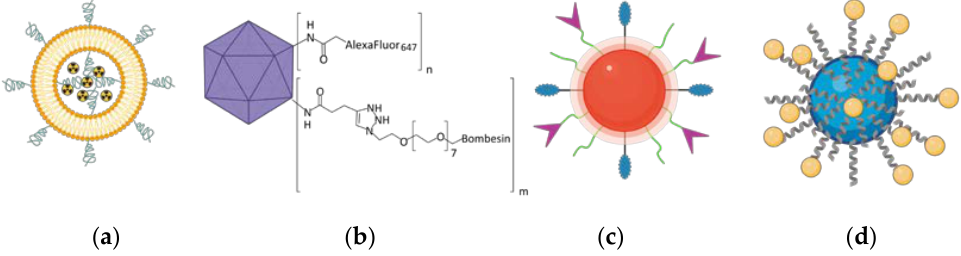
Figure 17. Other representative nanoformulations used for tumor imaging include ( a ) long-circulating, pH-sensitive, BBN-labeled liposomes with 99m Tc radiotracer (inspired by [75]), ( b ) dye-labeled, PEGylated cowpea mosaic virus (CPMV) conjugated with bombesin (inspired by [47]), ( c ) PEGylated, Gd 2 O 3 -based functional nanoparticles coupled with bombesin and 5(6)-carboxyfluorescein (inspired by [94]) and ( d ) lanthanide-oleate-based upconversion nanoparticles (UCNPs) functionalized with poly(acrylic acid) (PAA) and coupled with a BBN analog (inspired by [49]). Created with BioRender.com.